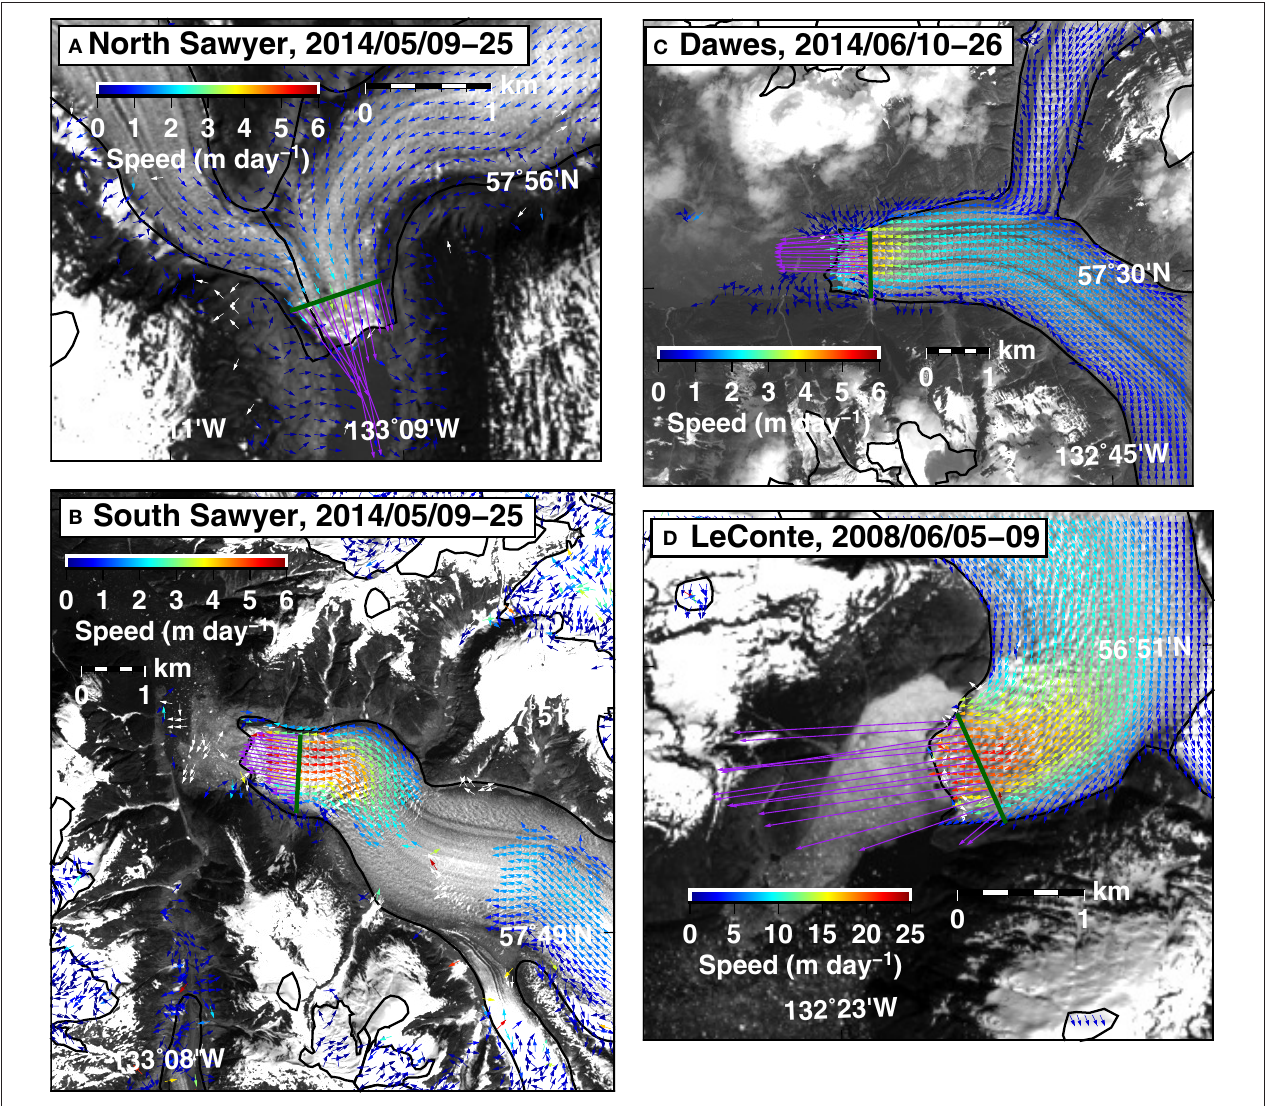
FIGURE 6 | Map of velocities at North Sawyer, South Sawyer, Dawes, and LeConte glaciers from selected pairs (A–D). Dark green lines indicate transects used to calculate flux from the mapped velocities. Purple arrows highlight the velocities at each transect. Black lines indicate glacier